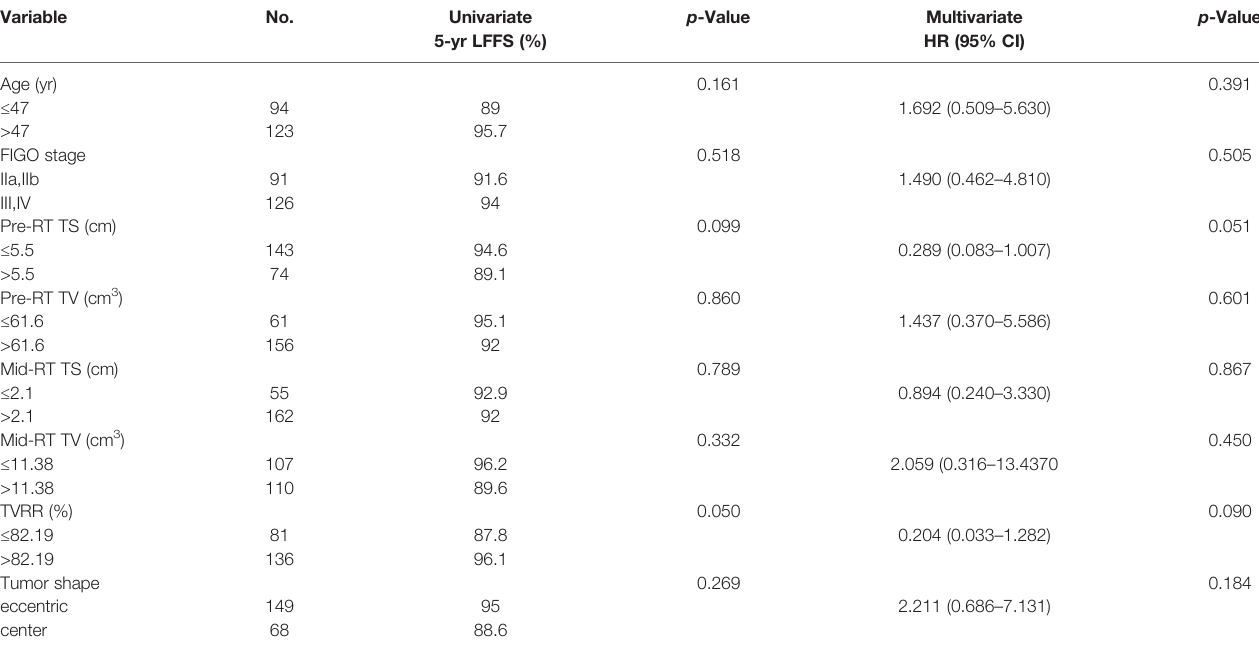
TABLE 5 | Prognostic analysis of local failure-free survival.